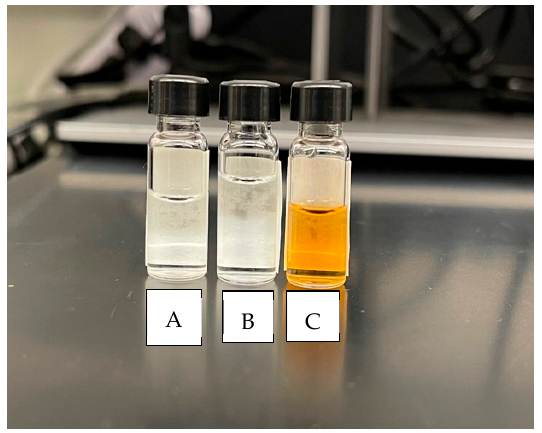
\ Figure 5. Artesunate reaction in ( A ) methanol Clear solution), ( B ) methanol:water (clear solution) and ( C ) 20 mM ammonium acetate: methanol (orange solution).